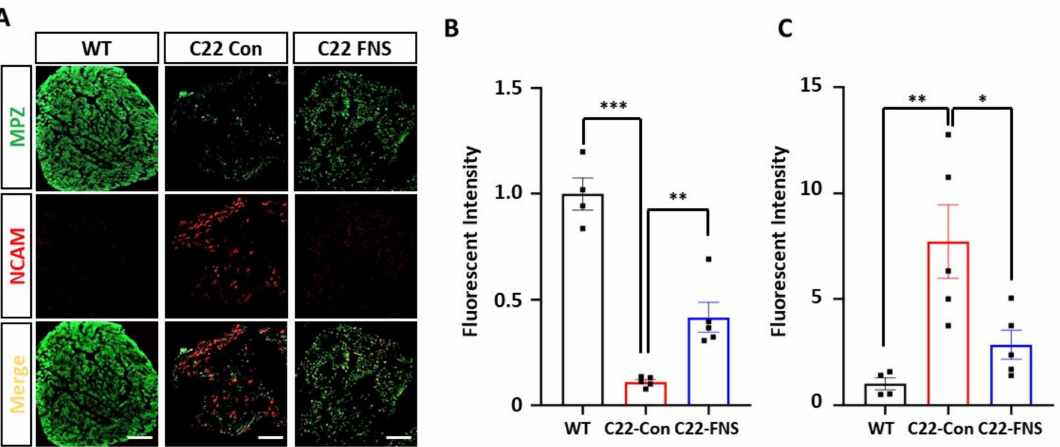
Figure 5. Restoration of sciatic nerve myelination by farnesol. ( A ) Immunofluorescent staining of MPZ and NCAM. Scale bar, 50 µ m. ( B ) Fluorescent intensity of MPZ. ( C ) Fluorescent intensity of NCAM. * p < 0.05; ** p < 0.01; *** p <